Question: Provide a one-line summary of what is displayed.
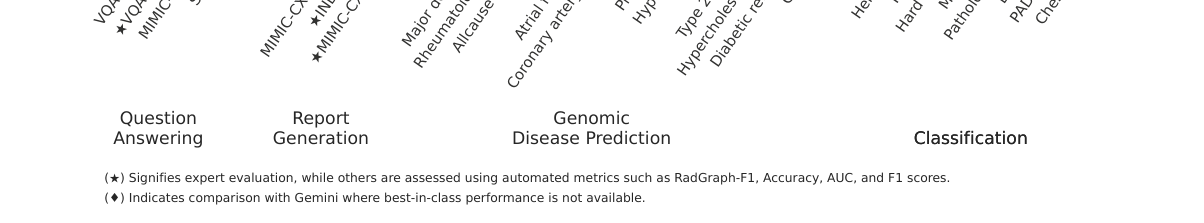
Answer: | Overview of our approach to curate and assess our family of medically tuned Gemini models, Med-Gemini. (top) These models build upon Gemini’s powerful capabilities in advanced reasoning, multimodal understanding, and long-context processing enriched with patient representation and medical knowledge. (bottom) Relative performance of Med-Gemini compared to SoTA or baselines across various tasks as detailed in Table A.15. Expert evaluation confirms that Med-Gemini-2D sets a new standard for AI-powered chest X-ray report generation, with relative improvements of 10% and 18% over the previous leading model across two distinct datasets. In histopathology, ophthalmology, and dermatology image classification, it surpasses baseline on 18 out of 20 tasks and approaches task-specific model performance. Med-Gemini-Polygenic outperforms the standard approach for disease risk prediction and generalizes to diseases for which it has never been trained.